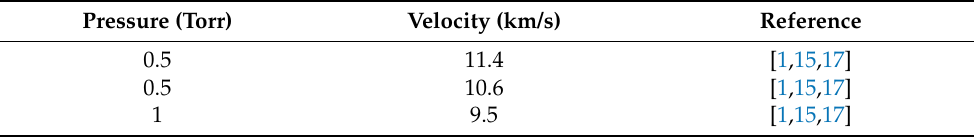
Table 1. Venus entry conditions investigated for VUV data measurements (1 Torr = 133